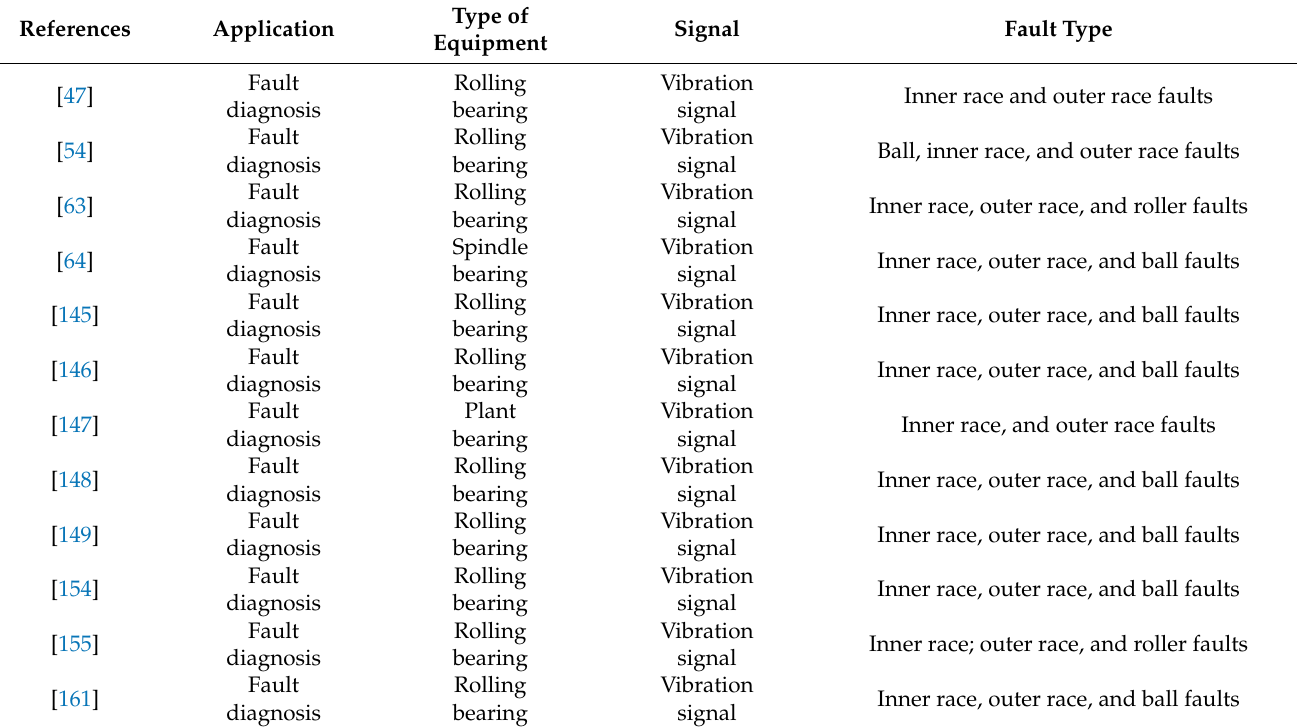
Table 20. Bearing condition monitoring using convolutional neural network.